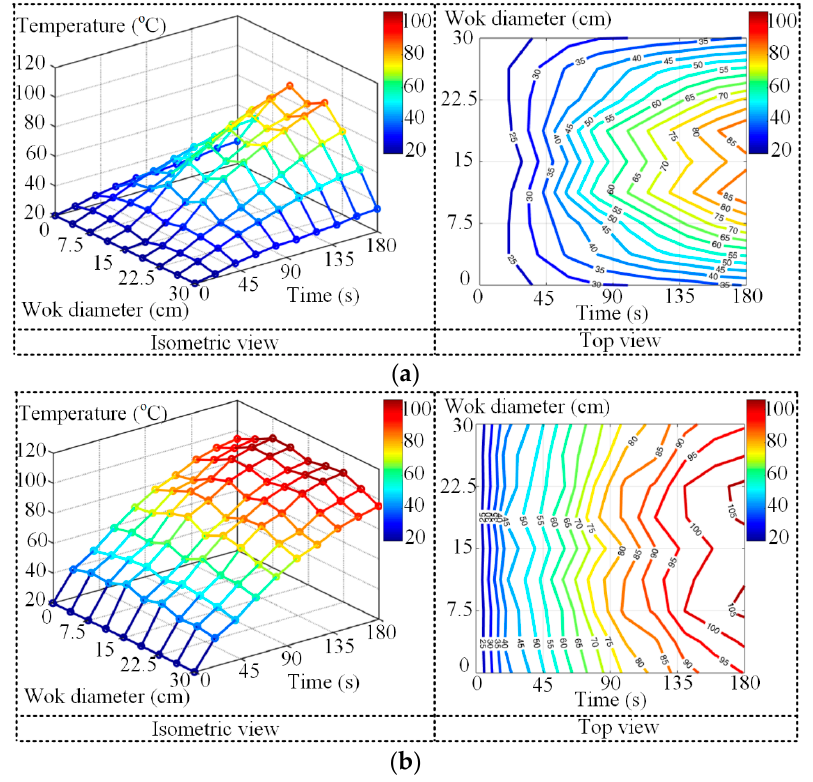
Figure 16. Temperature distributions. ( a ) Without frustum coil. ( b ) With frustum